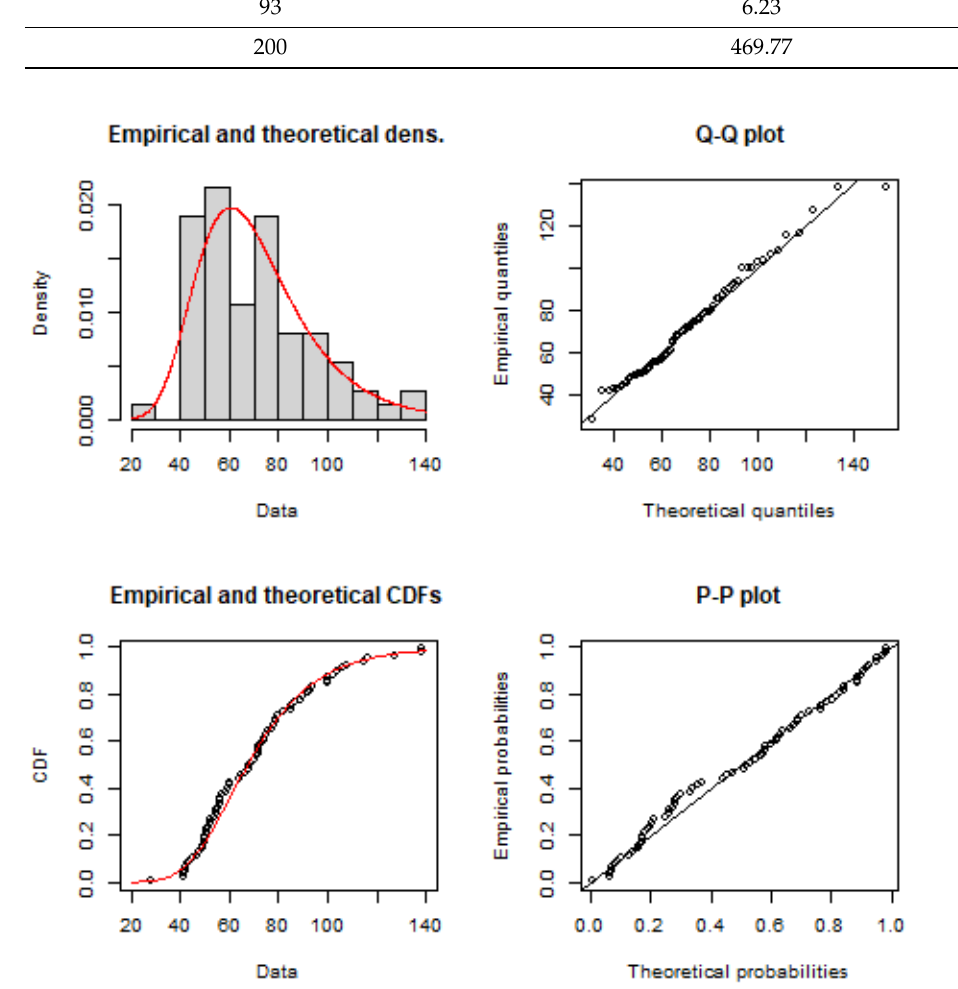
Figure 10. Gumbel distribution fitting.